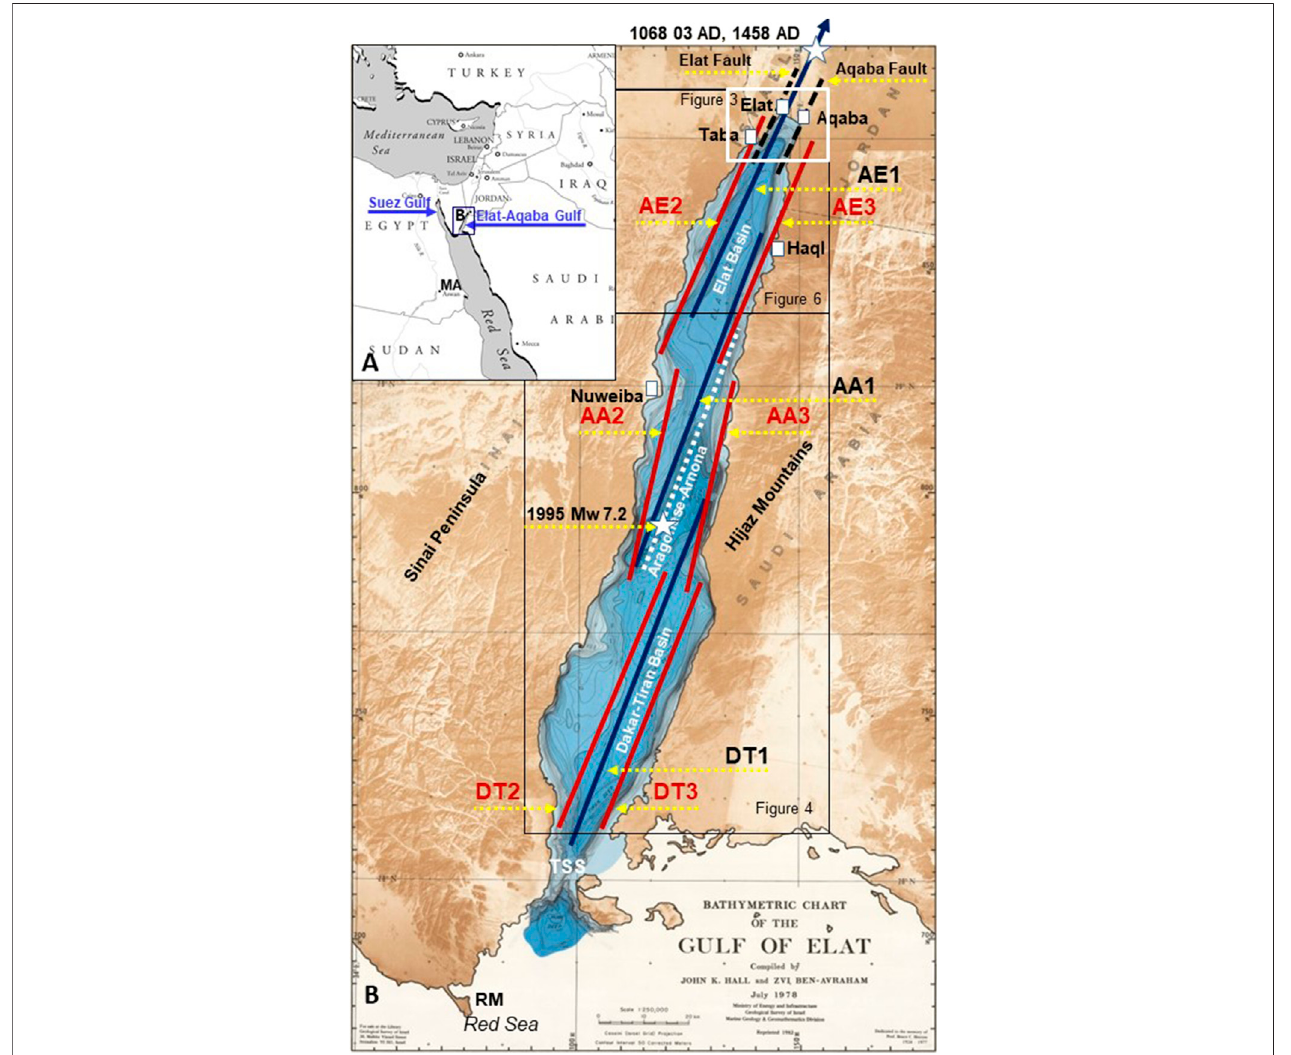
FIGURE 1 | Location maps of the study area. The white rectangle marks the Head of the Gulf of Elat-Aqaba (HGEA). (A) General setting (modi fi ed from https:// www.freeusandworldmaps.com/index.html).MA,MarsaAlam. (B) TectonicschemeofthepotentialtsunamigenicstructuresoftheGulfofElat – Aqabasuperimposedon the geography and bathymetry map (modi fi ed from Hall and Ben-Avraham, 1978). Black lines, schematic trace of the Dead Sea Transform by segments: Elat-Aqaba (AE1), Aragonese-Arnona (AA1) and Dakar-Tiran (DT1). Dark red lines, assumed western (AE2, AA2, DT2) and eastern (AE3, AA3, DT3) marginal faults of the basins.Dashed blacklines,Elat andAqaba faults. White dashed line,1995Nuweibaearthquakerupture(fromBaer etal.,2008).Stars,epicenterofstrong earthquakes; RM, Ras Muhammad; TSS, Tiran-Sharm El Sheikh Straits. The rectangles delimit the location of Figures 3 , 4 , and 6 .